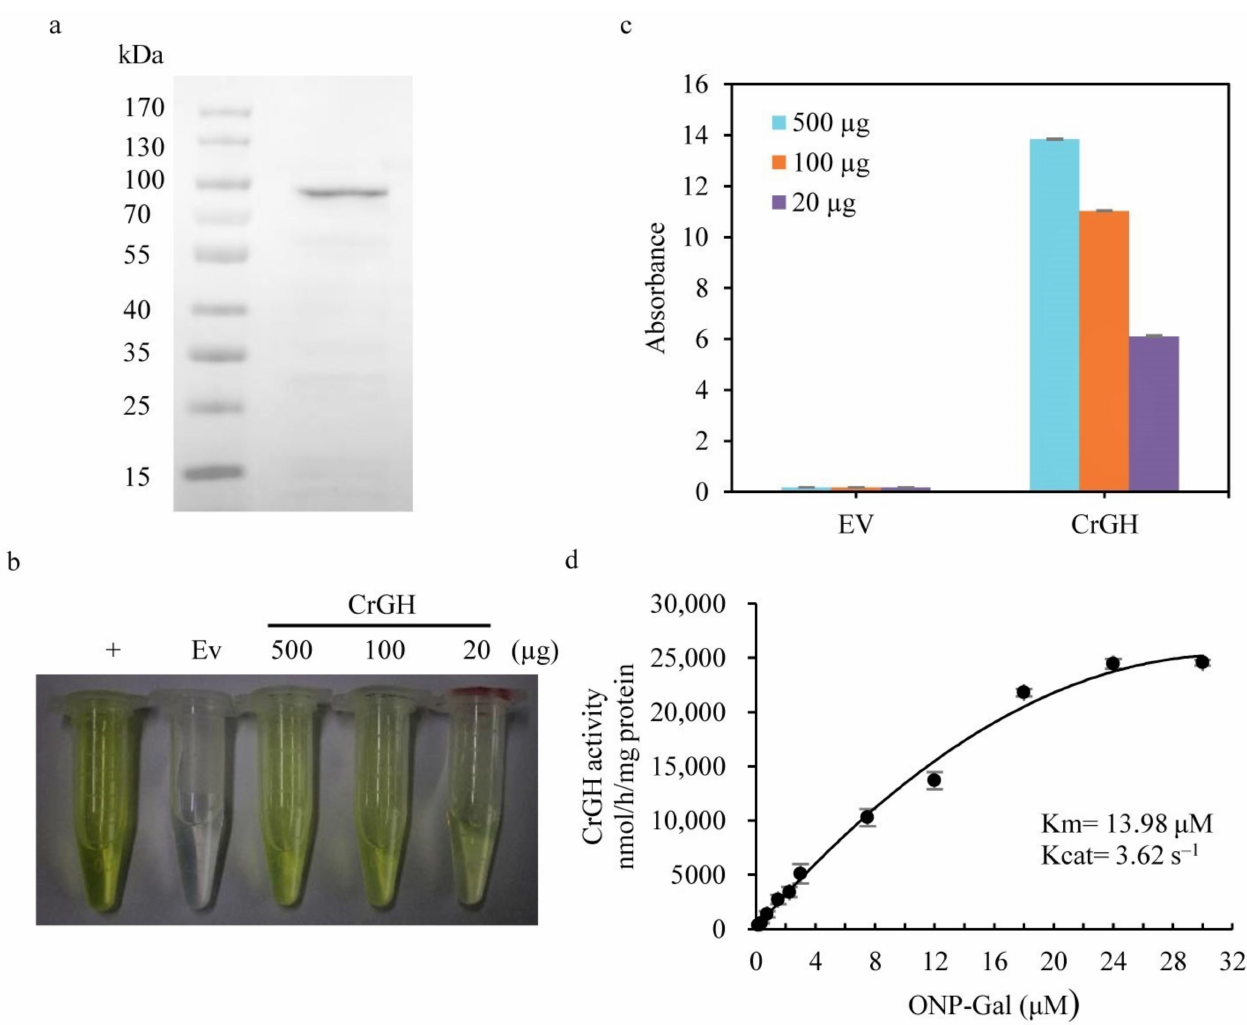
Figure 2. In vitro assay of the galactosyl hydrolase activity for the recombinant CrGH. ( a ). Expression of the recombinant CrGH in E. coli . ( b ). Enzymatic assay for CrGH with the substrate of ONP- β -D-galactopyranoside. EV, empty vector. The β - galactosidase from E. coli was used in the enzymatic reactions as a positive control. ( c ). Quantitation of the produced o-nitrophenol in enzymatic assays with various quantities of CrGH. ( d ). Kinetic determination of galactosyl hydrolase of the recombinant